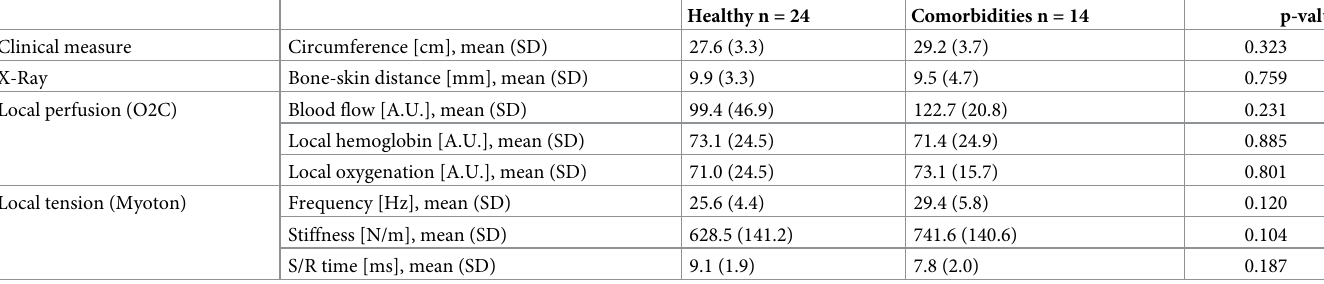
Table 4. Measurement of the soft tissue status in closed ankle or pilon fractures stratified according to